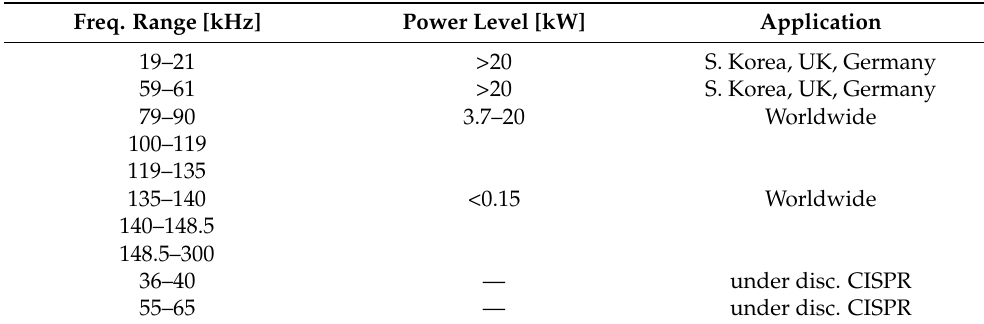
Table 1. Wireless Power Transfer for Electric Vehicles: standardized frequencies, power levels, and magnetic field